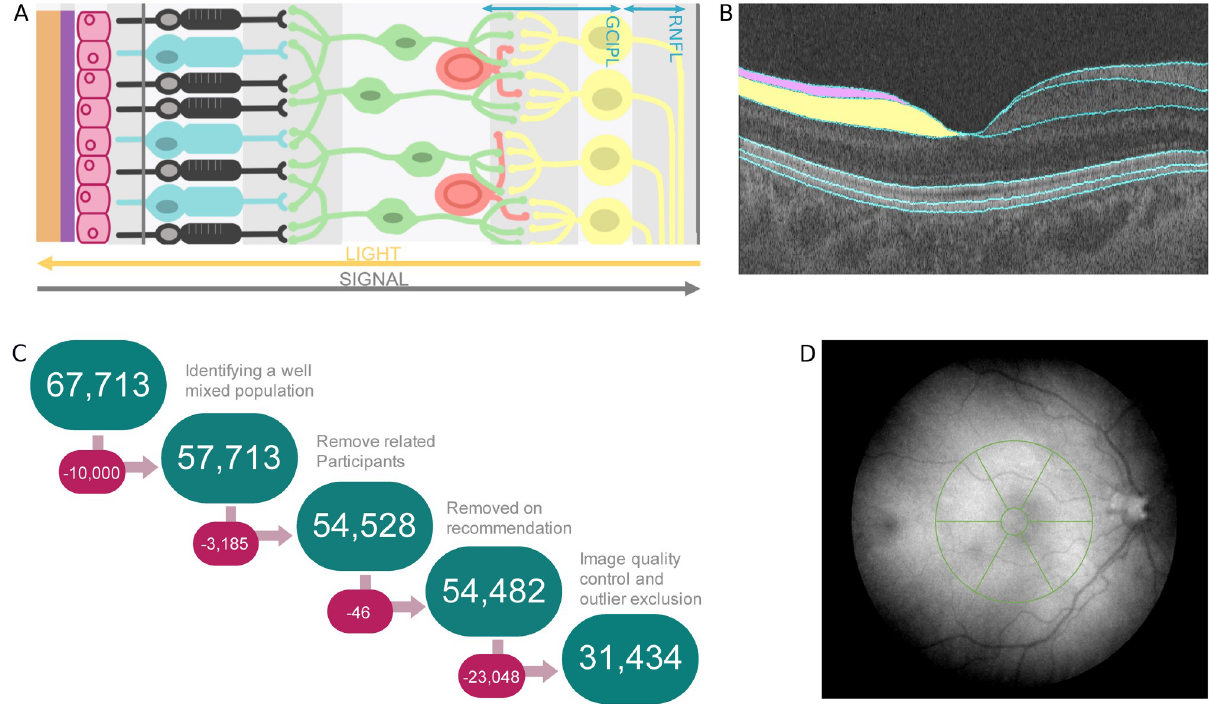
Fig 1. Retinal phenotype data and quality control. (A) A diagram illustrating the different retinal layers and the direction of travel for both the light stimulus and the neuronal signal. (B) An example of an Optical Coherence Tomography (OCT) image with segmented layer boundaries as labelled by the Topcon Advanced Boundary Segmentation (TABS) algorithm. On the left side of the image, the retinal nerve fibre layer (RNFL) is shaded pink, and the ganglion cell inner plexiform layer (GCIPL) is shaded yellow. (C) A schematic of the workflow applied during quality control, involving quality control of both the genotypic and phenotypic data. (D) A schematic of the Macula 6 grid, a commonly used partition matrix of the macular field when studying the inner retina. The matrix is comprised of 6 sections, with the central field being excluded from analysis.